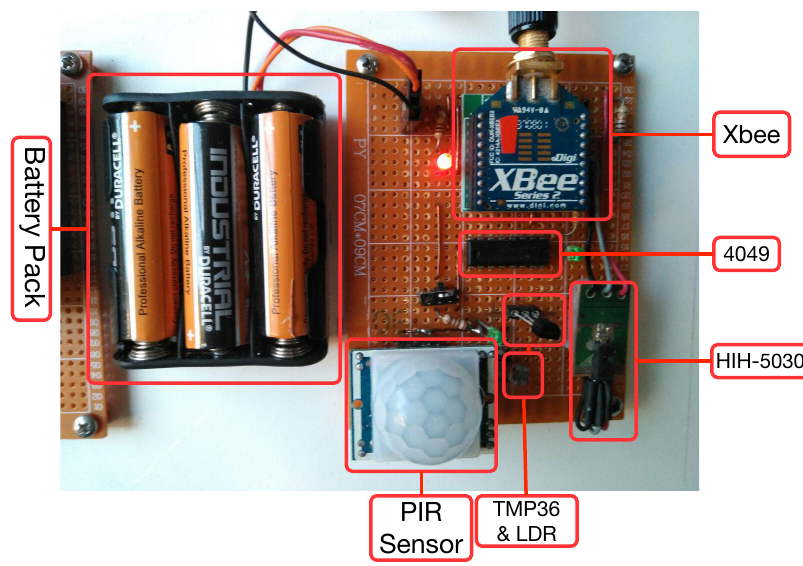
Figure 9. Prototype of the sensor node.